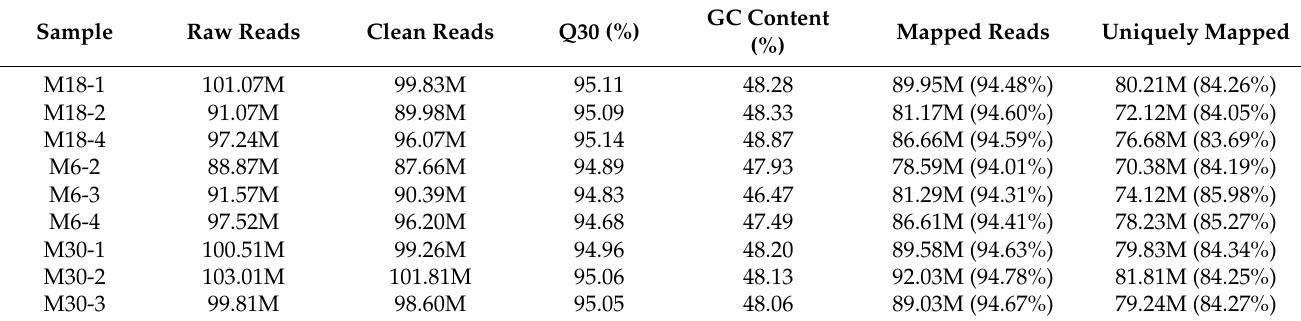
Table 1. Summary of RNA-Seq data and